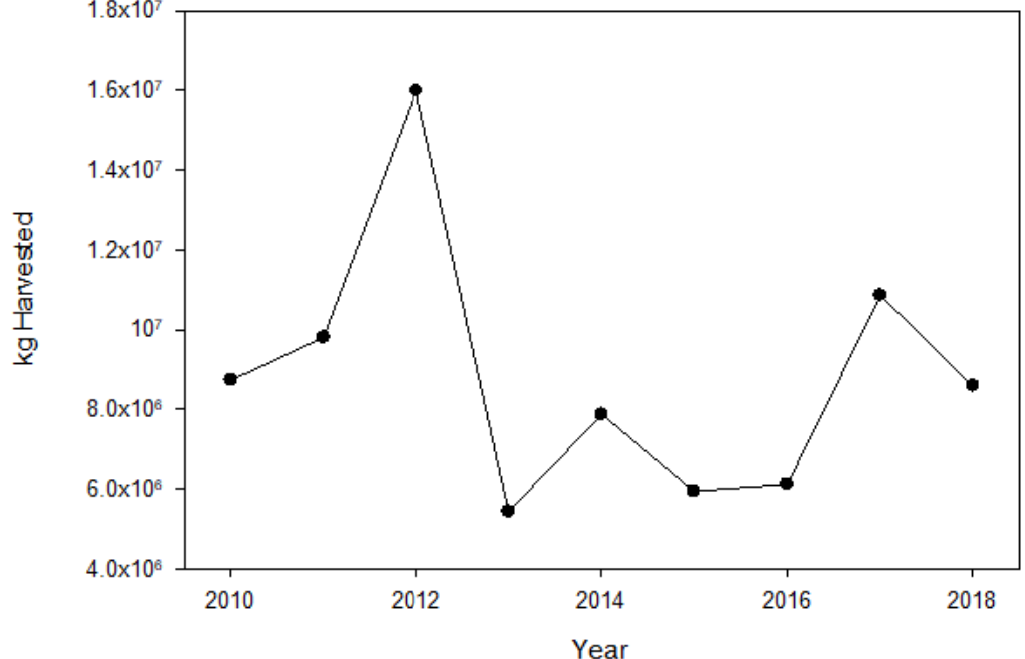
Figure 5. Total biomass in kg of bigheaded carp harvested from the lower Illinois River during the 2010–2018 period, derived from Illinois Department of Natural Resources records [43].